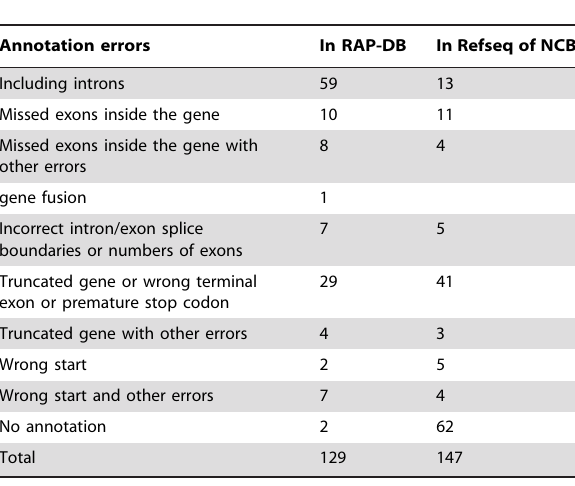
Table 1. Numbers of rice LK genes with annotation